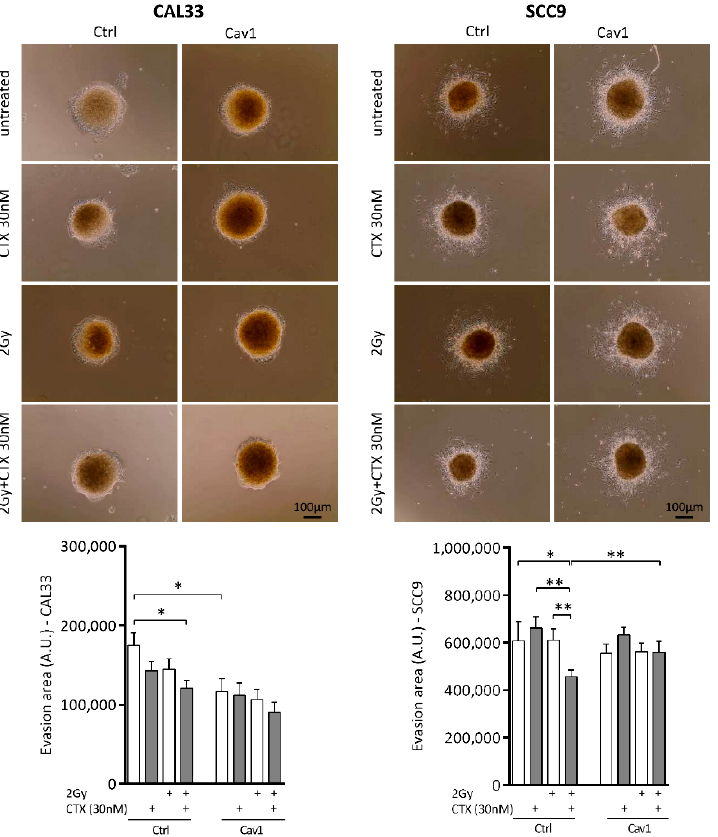
Figure 3. Overexpression of Cav1 maintains the evasive capacity of cells exposed to CTX alone or combined with irradiation. Analysis of collective cell migration: evasion of SCC9 Ctrl , SCC9 Cav1, CAL33 Ctrl and CAL33 Cav1 cells 24 h after treatment with 2 Gy irradiation, 30 nM cetuximab and a combination of both out of the spheroids. Pictures show the evasion area and histograms represent the mean ± SEM area covered by cells escaping from the spheroid ( n = 3–4, * p < 0.05, and ** p < 0.01). Thus, in addition to survival and growth preservation, Cav1 overexpression maintains the evasive capacities of cells exposed to